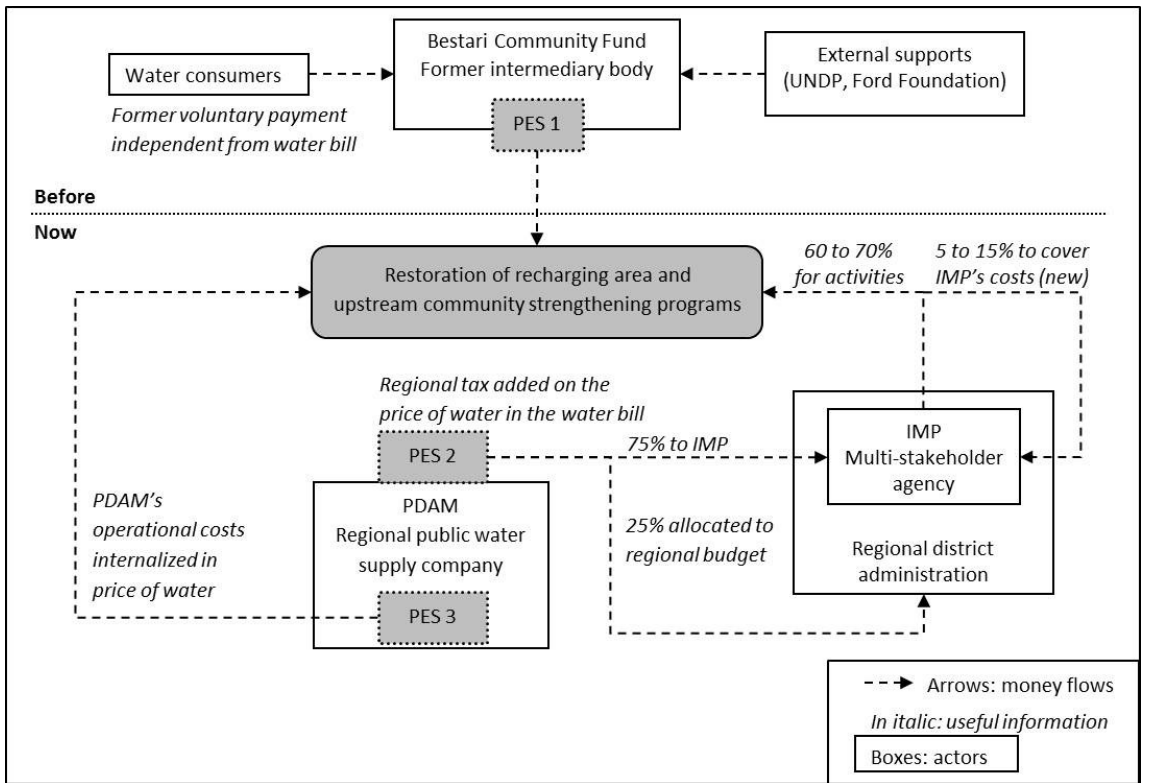
Figure 2. Governance structure of the three PES in Lombok. Source: